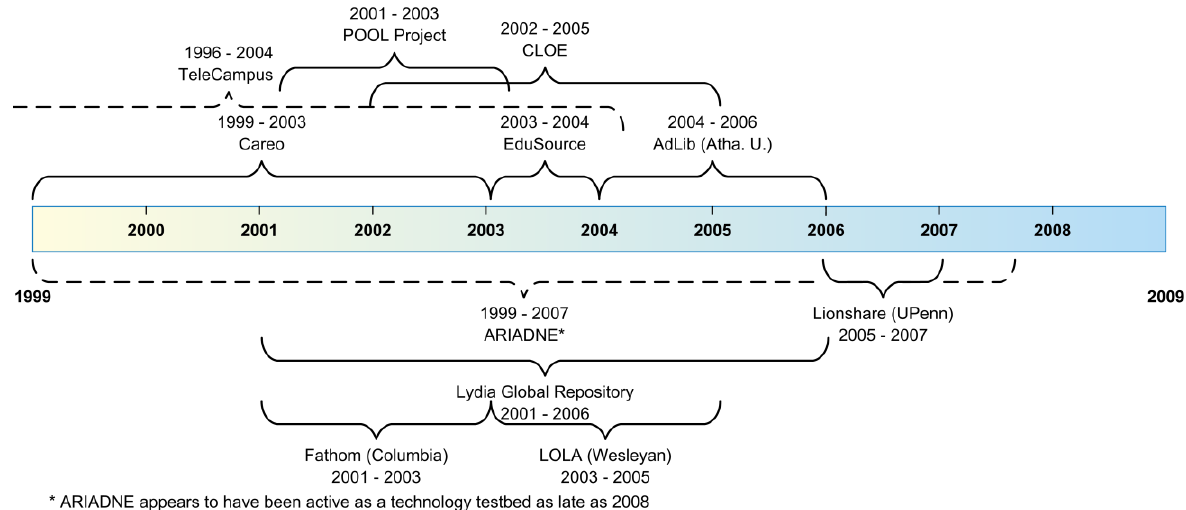
Figure 1 . Inactive or discontinued collection projects over the last 10